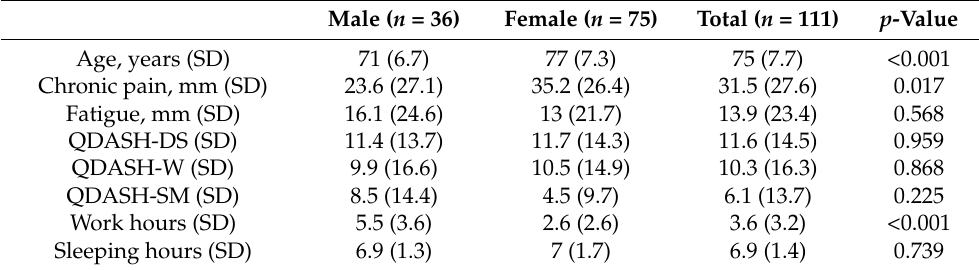
Table 1. Basic characteristics of the study participants by males and females.